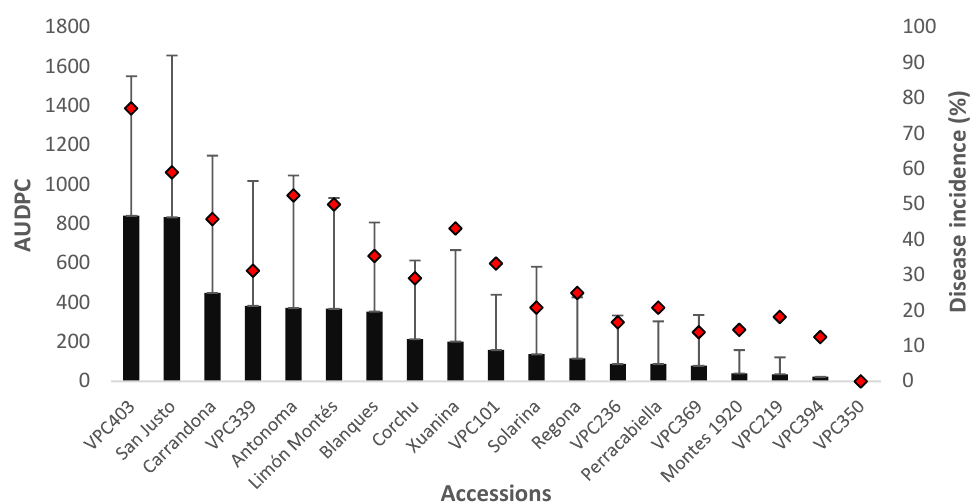
Figure 4. Mean area under disease progress curve (AUDPC; mean ± SD) and disease incidence (proportion infected wounds as a percentage of the number of inoculated wounds) for adult trees inoculated with field-collected inoculum calculated 234 days post-inoculation. The solid black bars represent AUDPC values, whereas the red rhombuses indicate the disease incidence percentage.